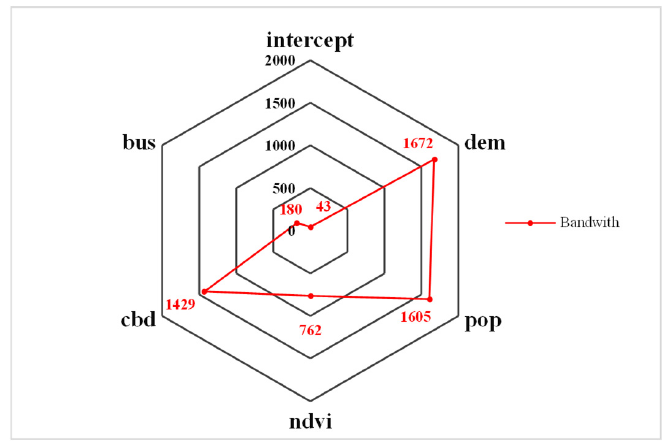
Figure 7. Bandwidths for explanatory variables in MGWR.